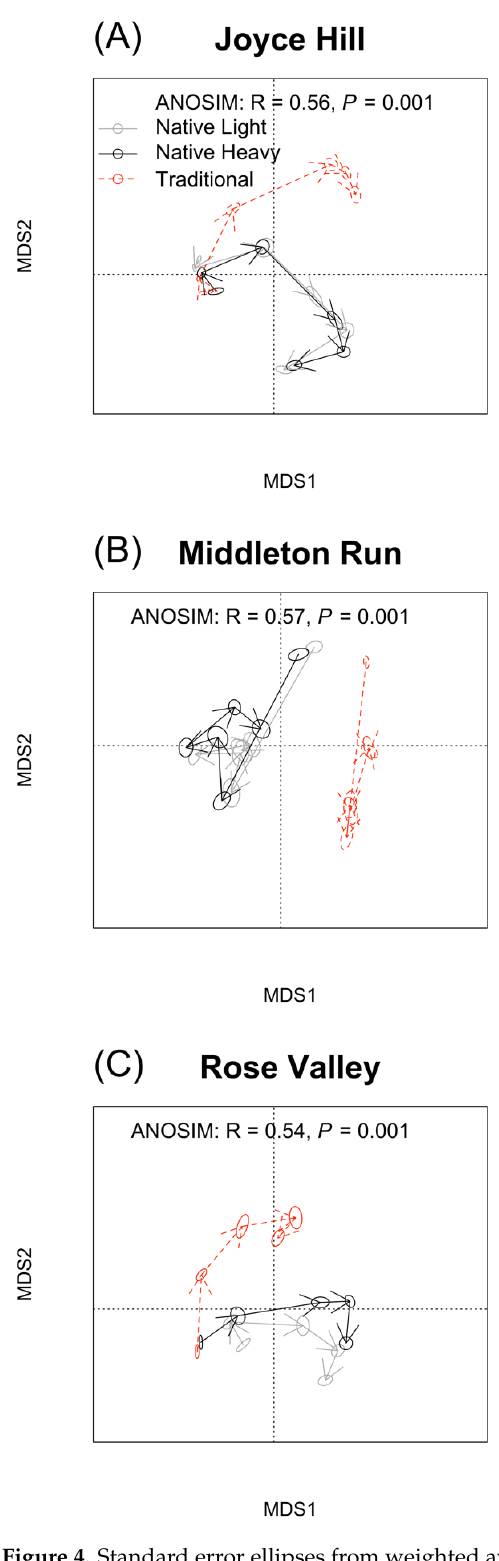
Figure 4. Standard error ellipses from weighted average of metric dimensional scaling (MDS; also known as principal coordinates analysis [PCoA]) scores of seed treatment by growing season groups at each site, ( A ) Joyce Hill, ( B ) Middleton Run, ( C ) Rose Valley. Arrows represent movement in ordination space of seed treatments from growing season to growing season.